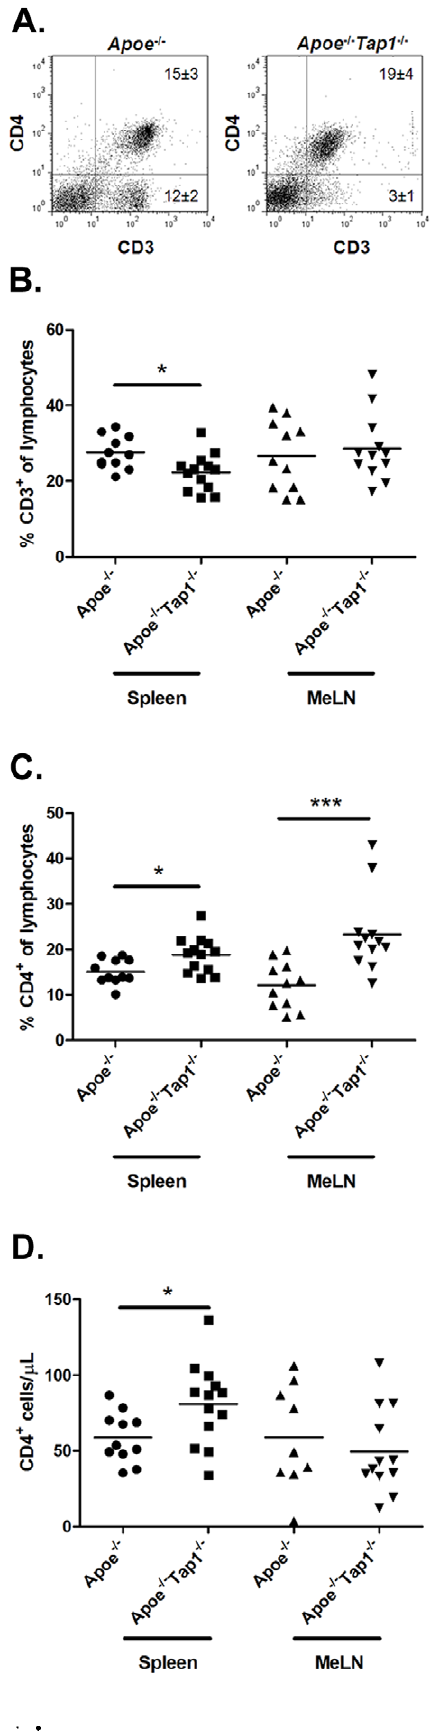
Figure 3. CD3 + T cells and CD4 + T cells in spleen and MeLN. Flow cytometry graphs showing the cell populations in spleen from one representative mouse from each group (A). Numbers given in the graphs are per cent cells out of all lymphocytes. The fraction of CD3 + T cells (B), CD3 + CD4 + T cells (C) and CD3 + CD4 + T cell numbers (D) in Apoe 2 / 2 and Apoe 2 / 2 Tap1 2 / 2 mice in spleen and MeLN. The cells were isolated from respective tissue, stained with fluorescent antibodies and analyzed by flow cytometry. Each dot in the figure represents one mouse. * P , 0.05, *** P ,